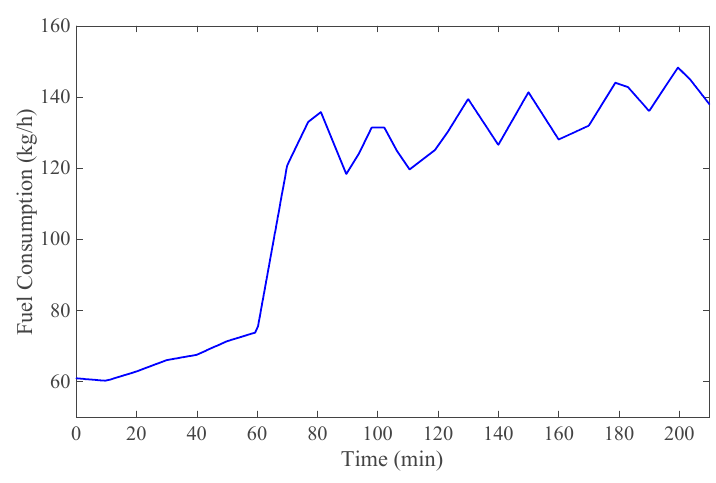
Figure 12. Fuel consumption per hour.